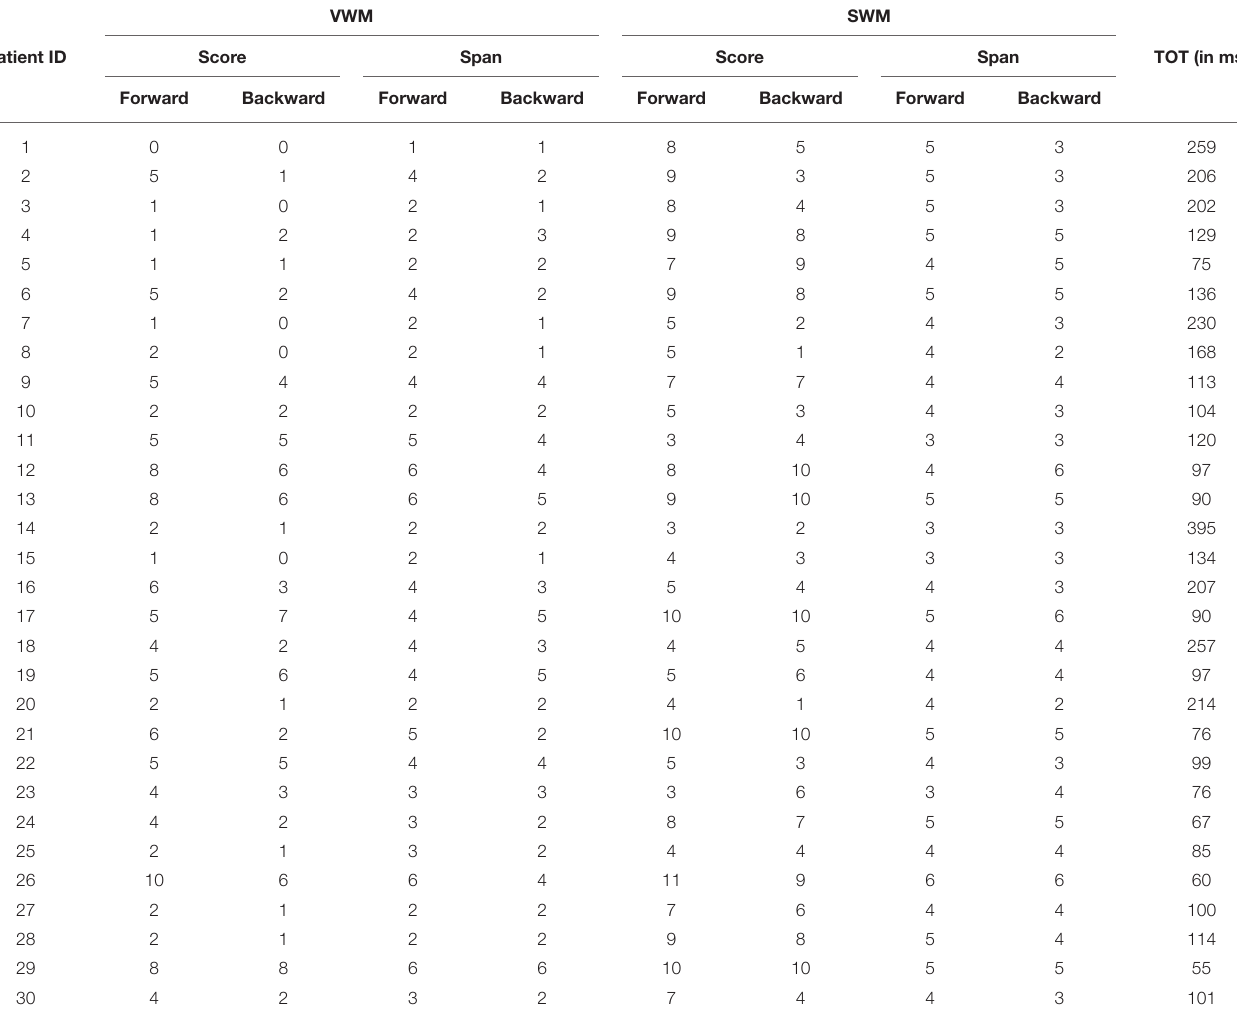
TABLE 3 | Individual data for VWM and SWM in the backward and forward tasks (scores and spans for each participant), along with temporal order threshold (TOT). VWM SWM Patient ID Score Span Span